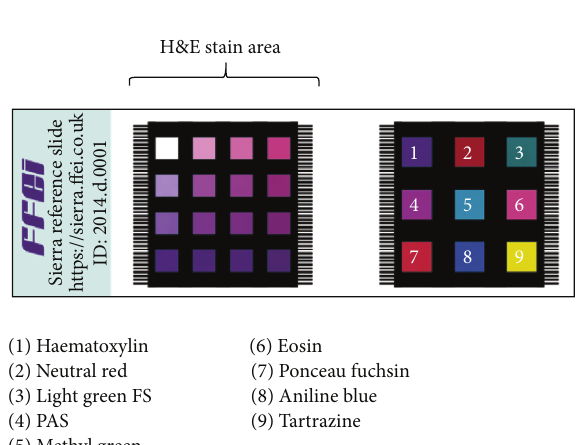
Figure 2: WSI image